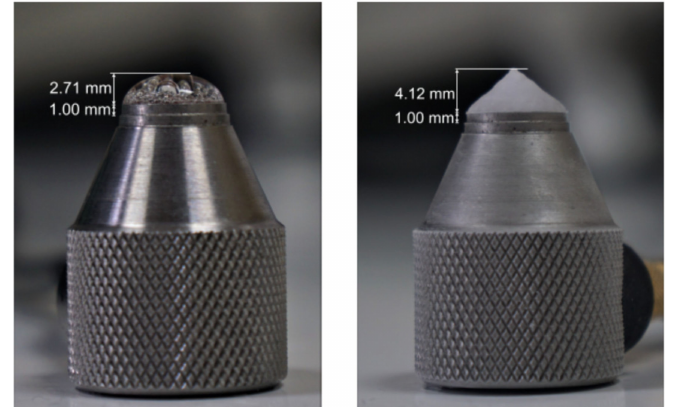
Figure 8. Optical determination of drop height at room temperature ( left panel), or as a frozen drop ( right panel). These pictures correspond to Ice Drop Experiment 2, discussed in the body of the